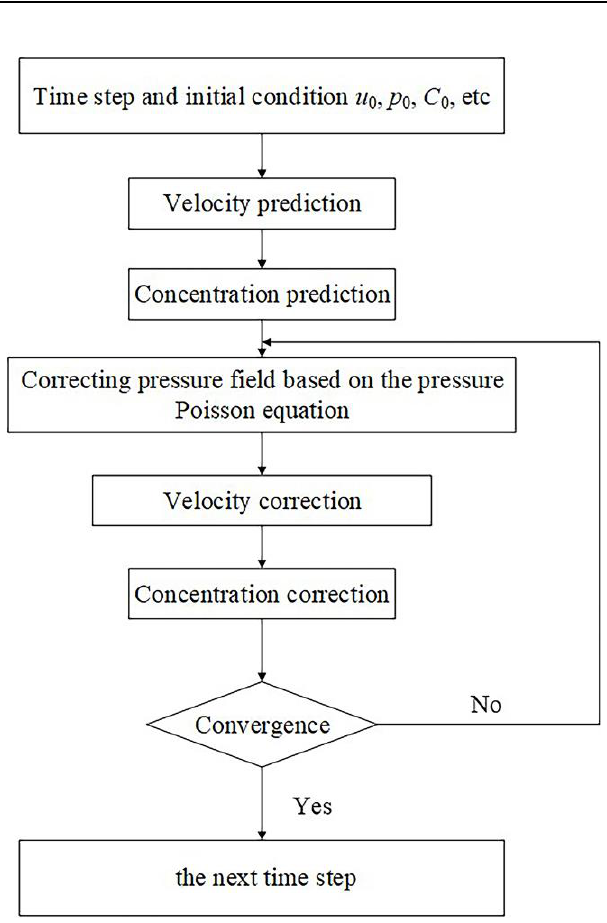
Figure 3. Calculation flow chart.